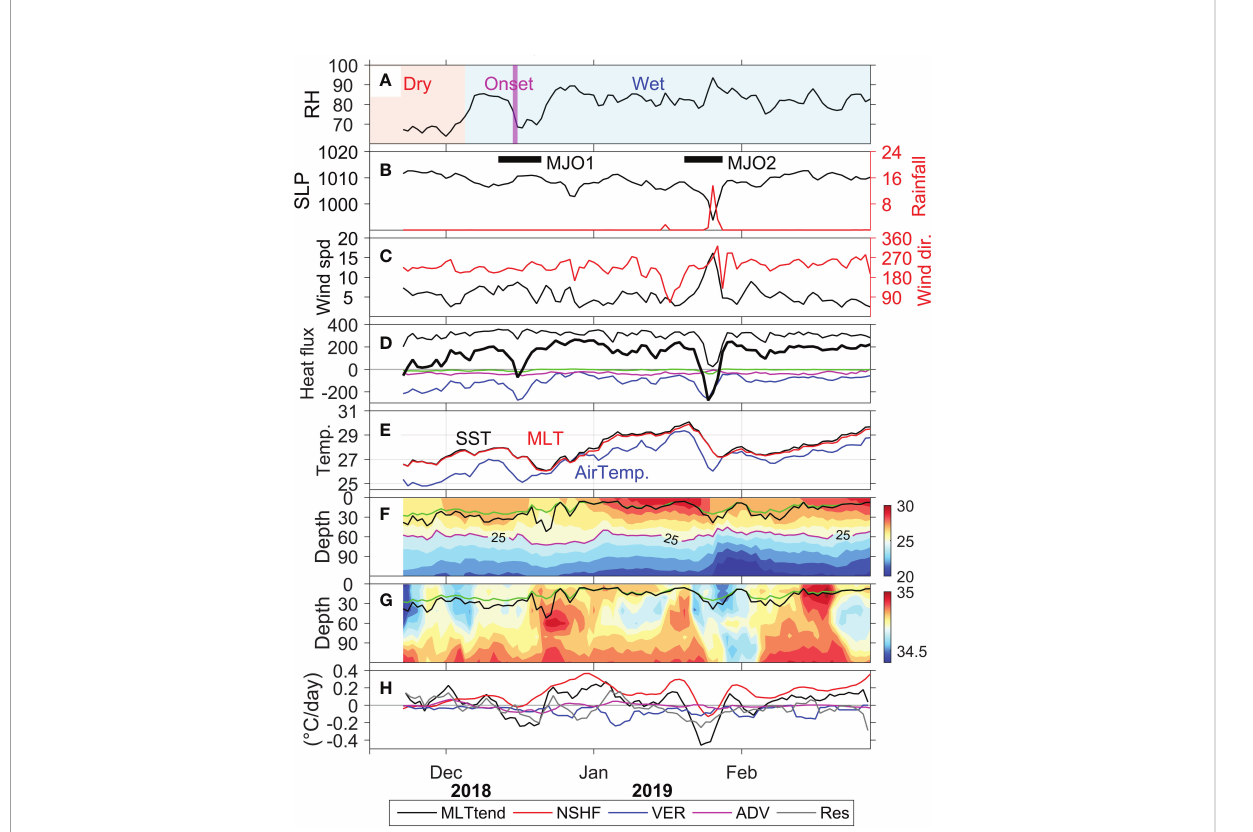
FIGURE 5 Daily time series of the buoy-measured (A) relative humidity (%); (B) sea-level pressure (black line; mb) and rainfall (red line, mm day − 1 ); (C) wind speed (black line, m s − 1 ) and wind direction (red line); (D) shortwave radiation (thin black line; W m − 2 ), longwave radiation (magenta line; W m − 2 ), latent heat fl ux (blue line; W m − 2 ), sensible heat fl ux (green line; W m − 2 ), and net air – sea heat fl ux (thick black line; W m − 2 ); (E) air temperature (blue line; °C), SST (black line; °C), and MLT (red line; °C); (F) upper ocean temperature (°C); (G) salinity (psu); and (H) the 5-day running averaged MLT budget components (°C day − 1 ) from November 2018 to February 2019. Dry and wet stages of the 2018/2019 IASM are shaded and labeled based on the humidity evolution in (A) , with the thick magenta bar indicating the IASM onset date in the present study. Black horizontal bars in (B) denote the active periods of the MJO events as in Figure 2A. Positive heat fl ux in (B) represents a gain to the ocean. The green and black lines in (F, G) represent the MLD and ILD,